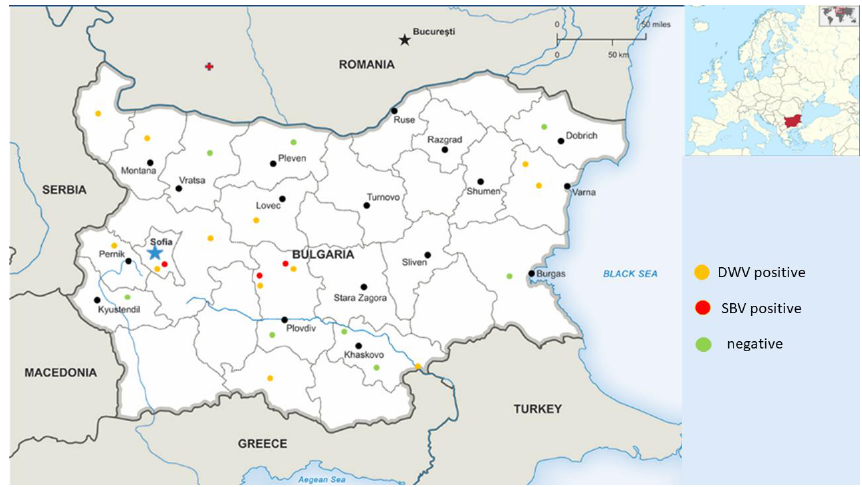
Figure 1. Map showing the geographic localization and the positive and negative (DWV and SBV) pollen samples.